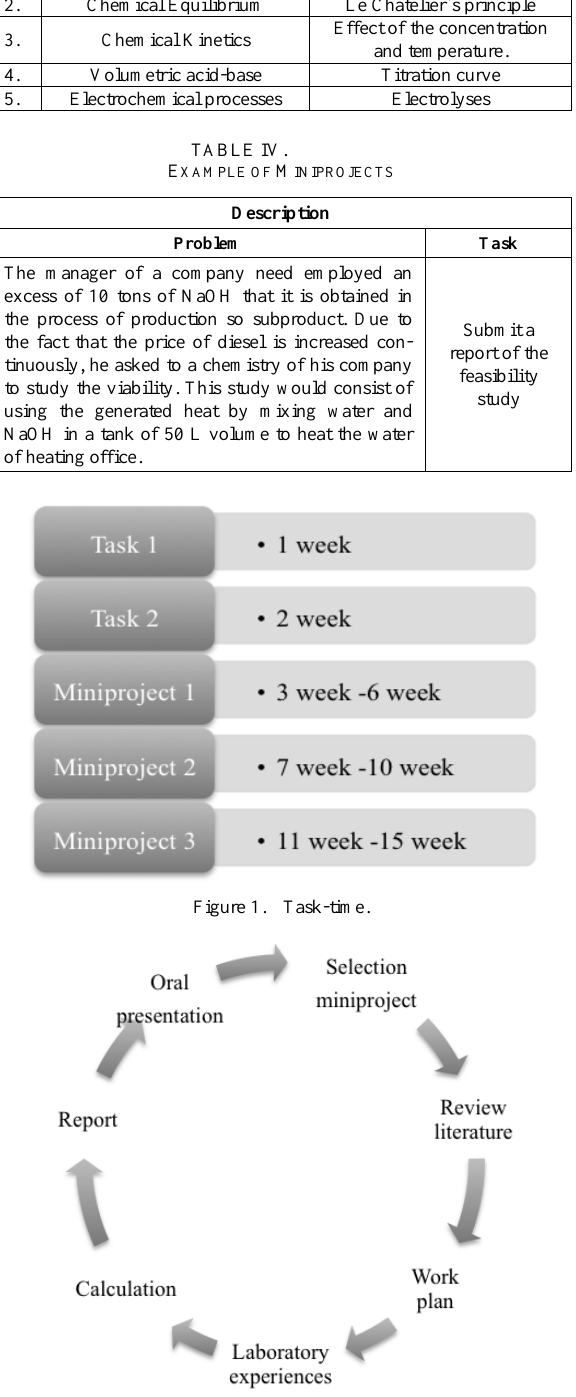
Figure 2. Flowchart of a